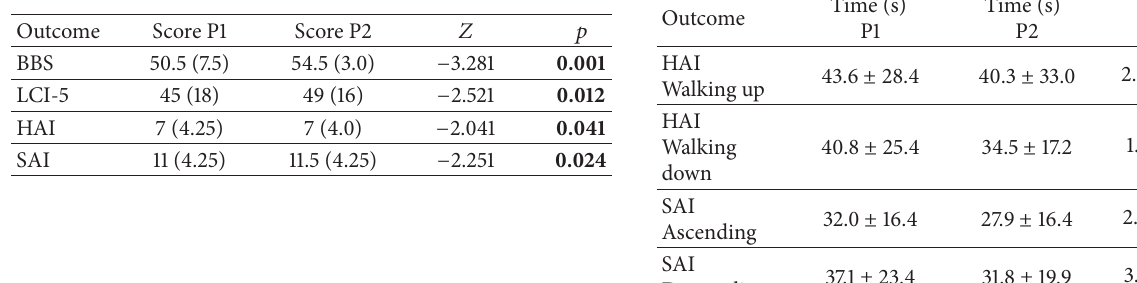
Table 2: Score results of Berg Balance Scale (BBS), Locomotor Capability Index-5 (LCI-5), Stair Assessment Index (SAI), and Hill Assessment Index (HAI) during data collection sessions fitting the SACH (P1) and the multiaxial foot (P2) compared by means of a nonparametric Wilcoxon signed rank test. Data shown in this table are expressed as median (interquartile range); 𝑍 and 𝑝 values (significant in bold) are reported.